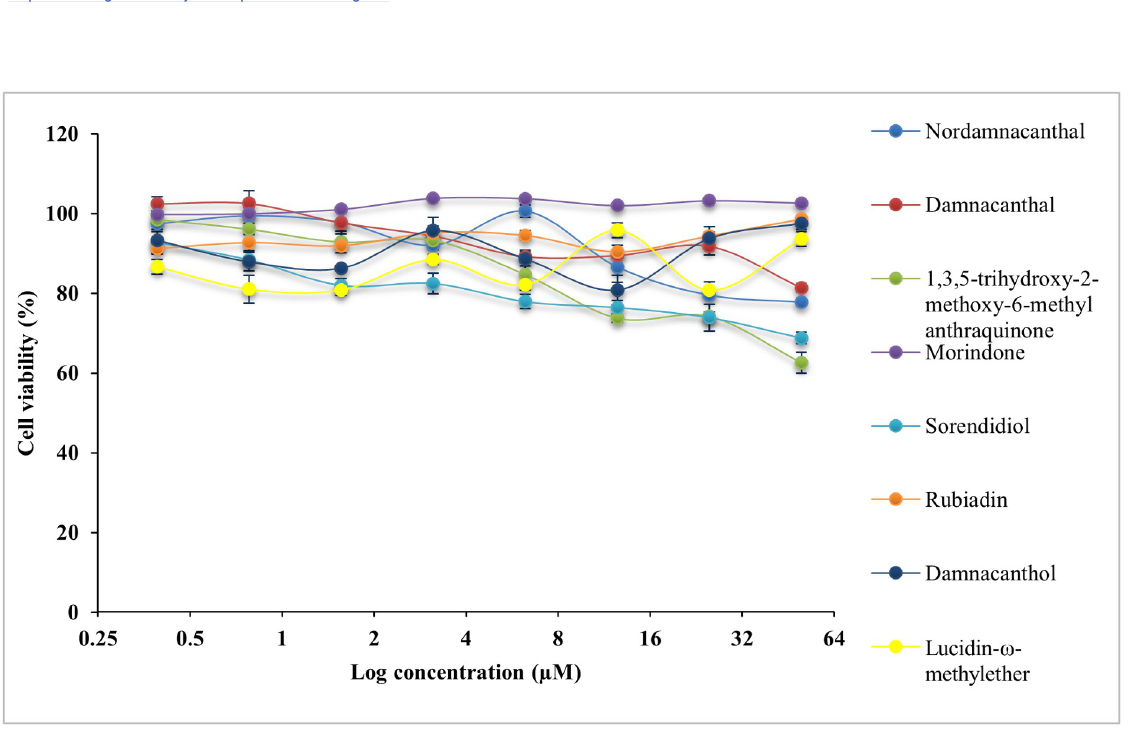
Fig 7. Cytotoxicity effect of anthraquinone compounds 1–8 on the cell viability of CCD841 CoN cells. Data was shown as mean ± SD from three independent experiments.